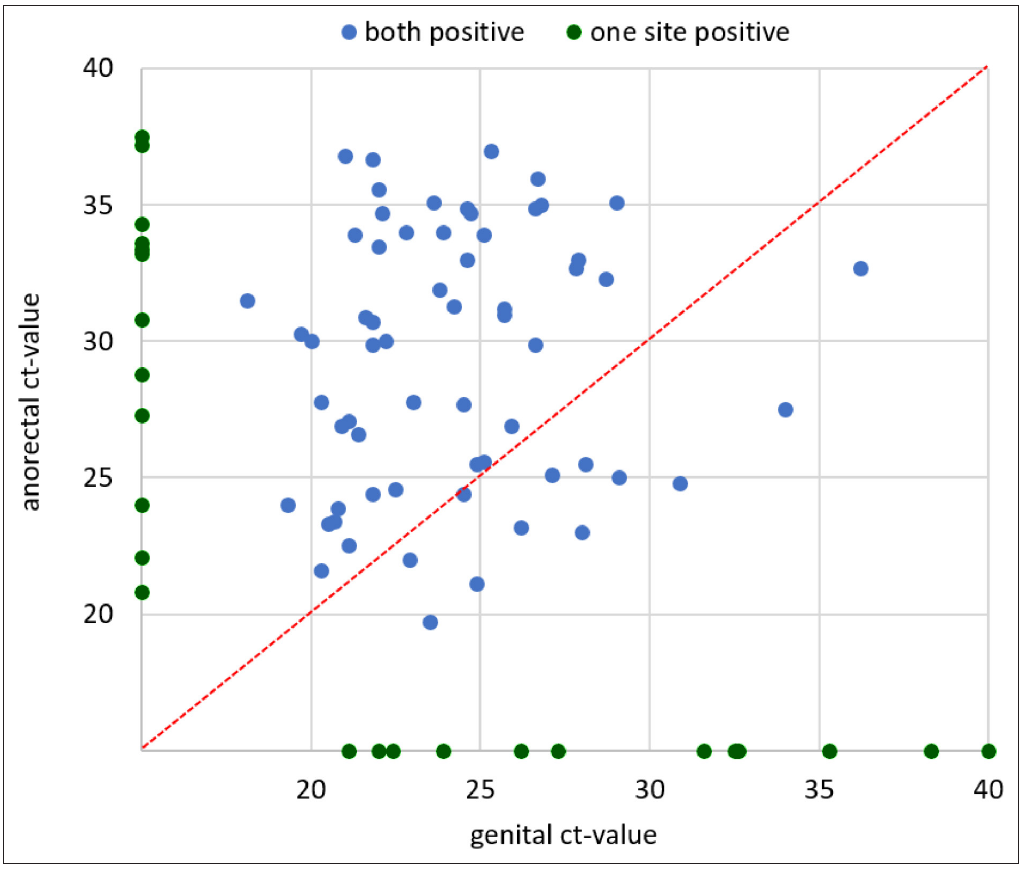
chain reaction (PCR)